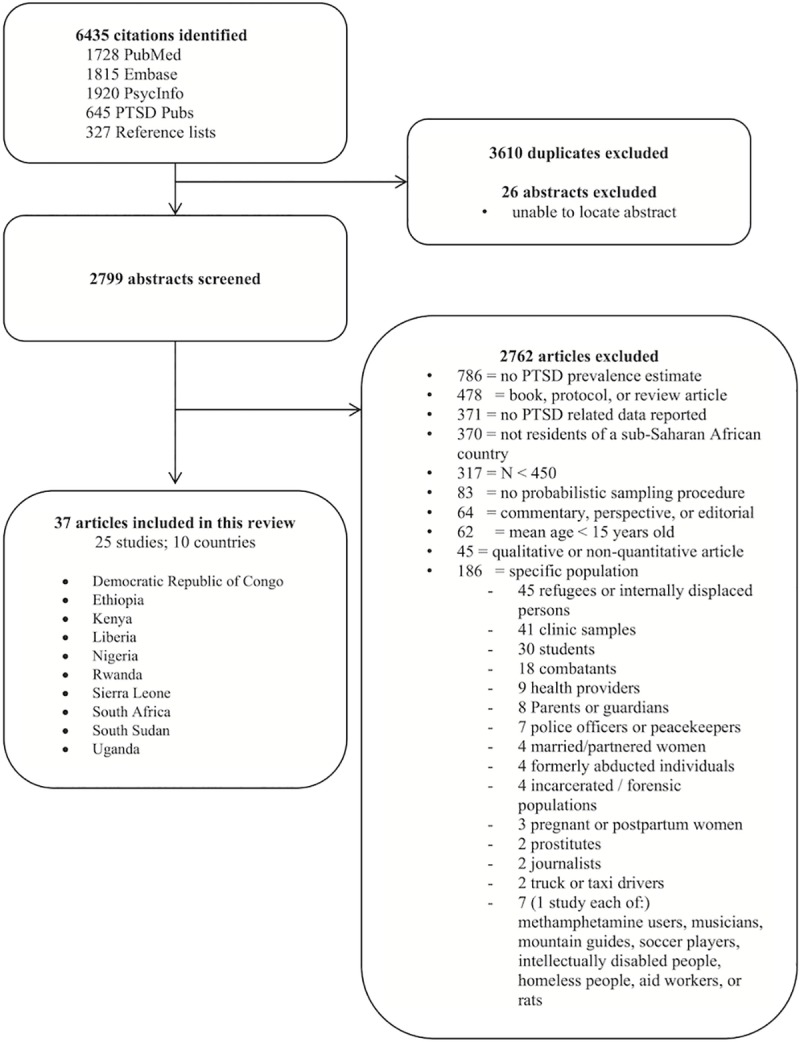
Study selection flow diagram.PTSD, posttraumatic stress disorder.